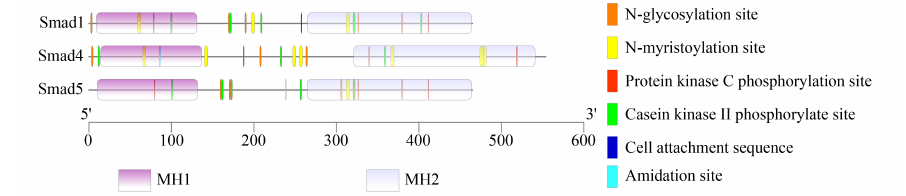
Figure 7. The putative modification sites in buffalo Smads 1 , 4 , and 5